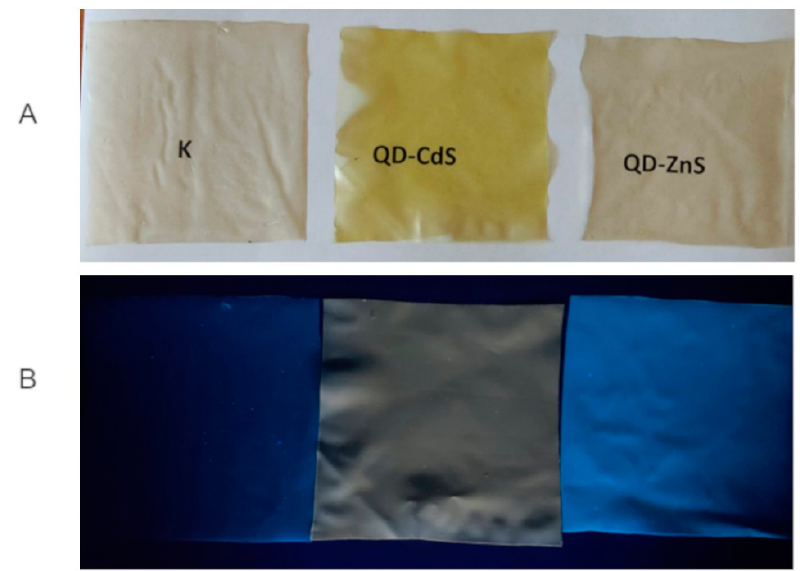
Figure 1. Starch–chitosan films: ( A )—in daylight, and ( B )—in the dark excited with the UV (365 nm) radiation.